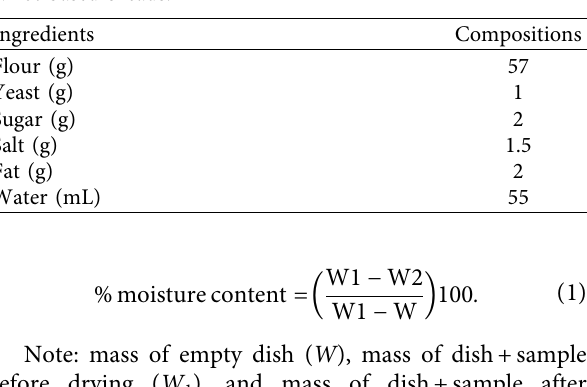
Table 1: Formulation of four blends of wheat, banana, and carrot in dry weight for bread